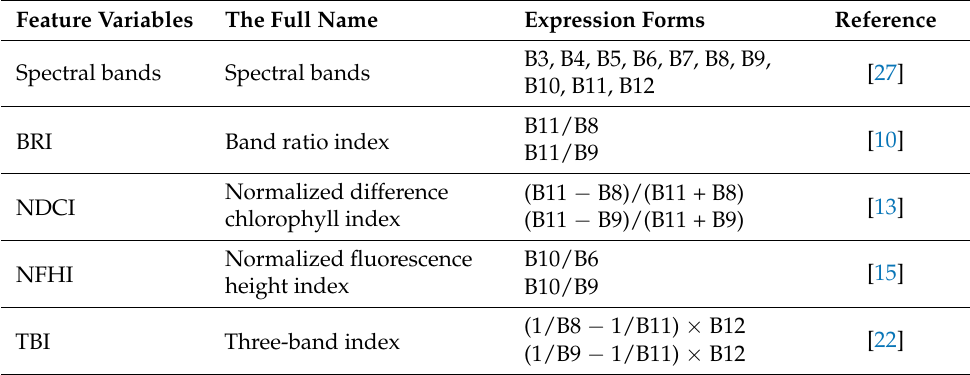
Table 2. Description of the input variables from